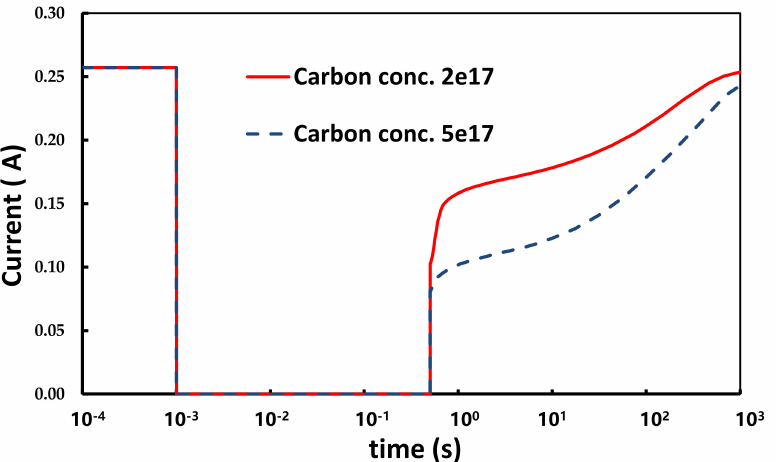
-1.5-1.0-0.50.00.51.01.52.02.53.03.5